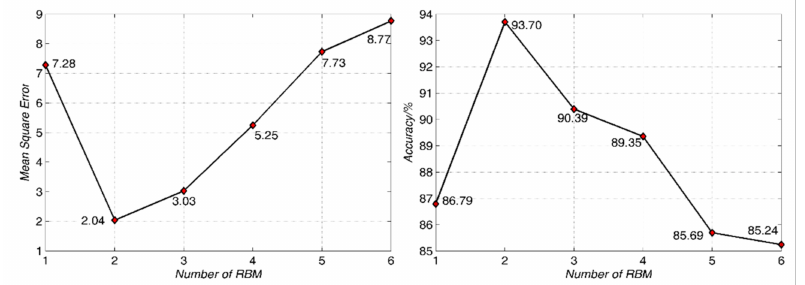
Figure 9. The output mean square errors and classification performances in different restricted Boltzmann machines (RBMs) for the Qionglai ceramics.